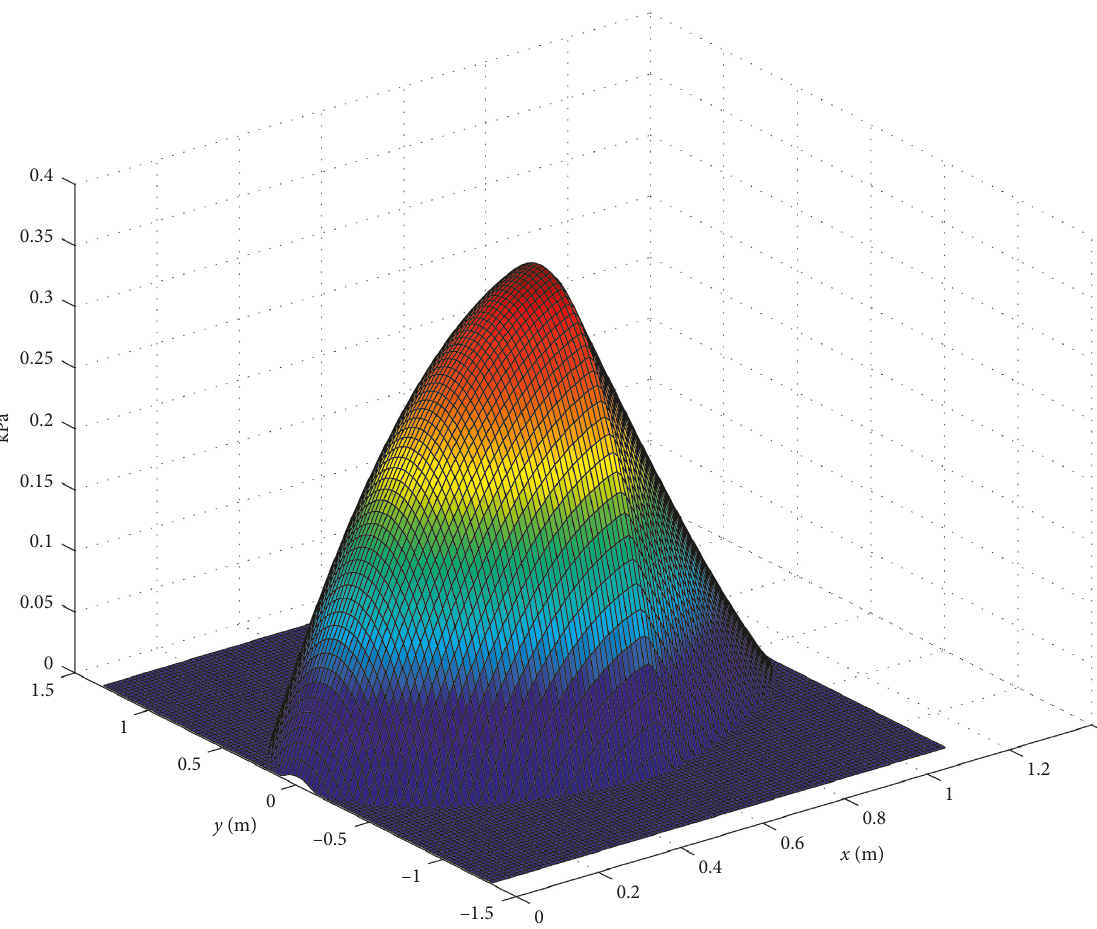
Figure 8: The distribution of normal stresses for case